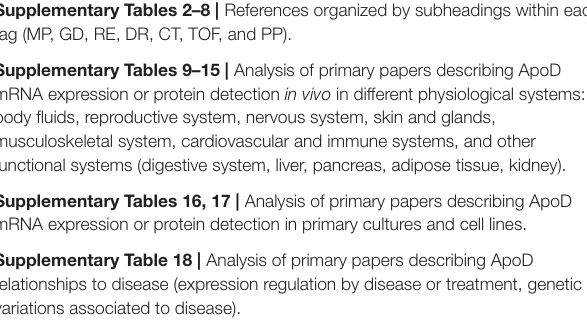
Supplementary Figure 1 | ApoD mRNA and protein expression summary of the Human Protein Atlas. Supplementary Figure 2 | ApoD mRNA and protein expression summary of the Mouse Gene Expression Database. Supplementary Table 1 | Complete ApoD Reference